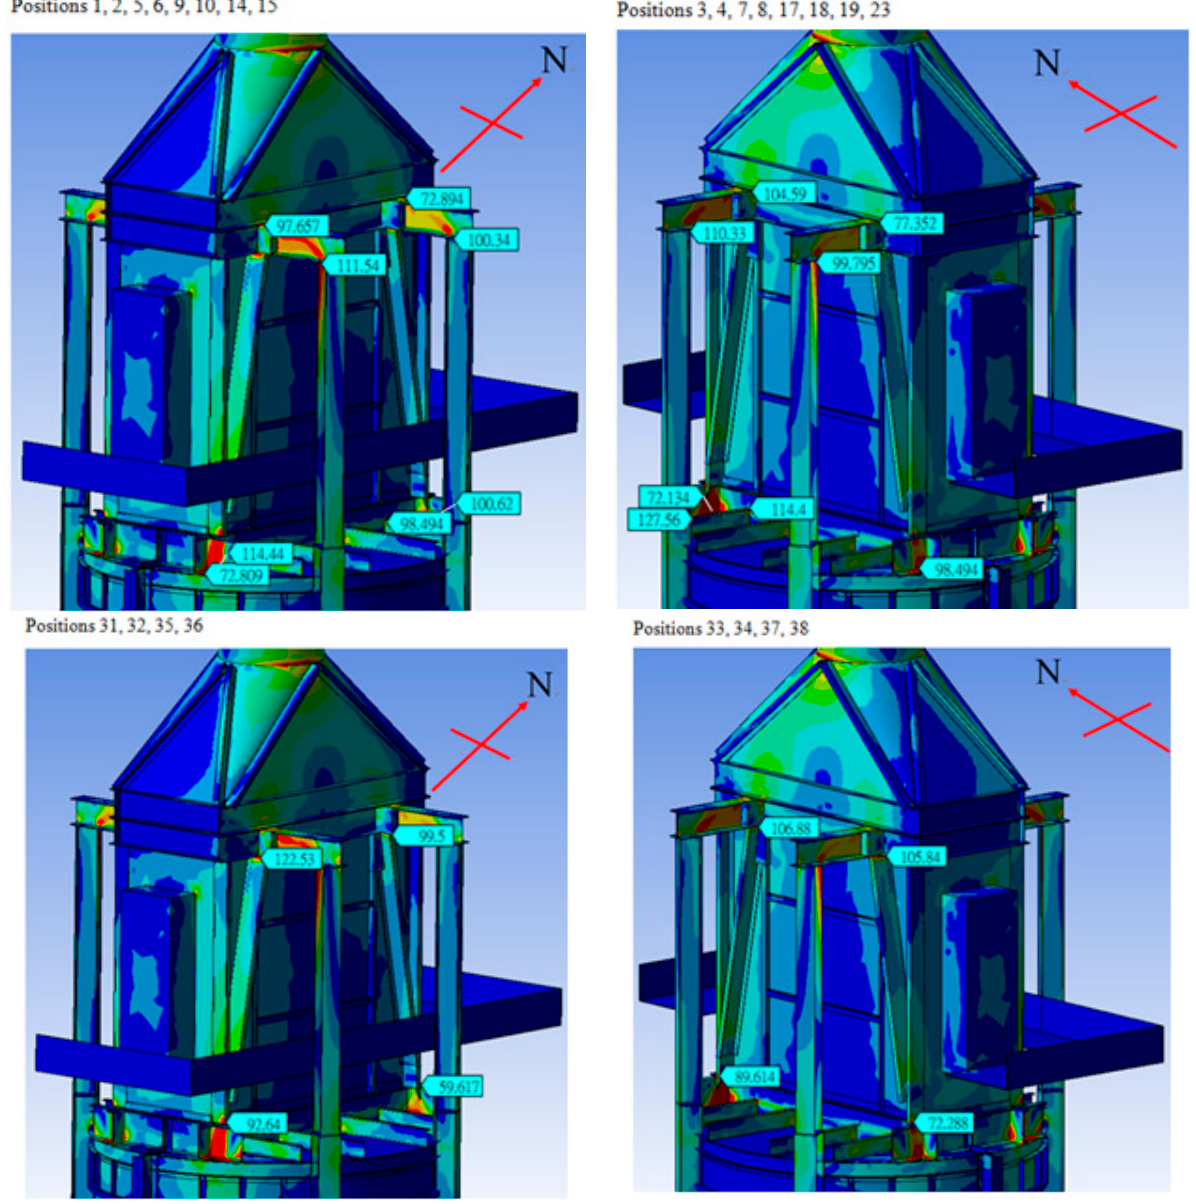
Figure 5. Results of finite element analysis for the heater before reinforcement.